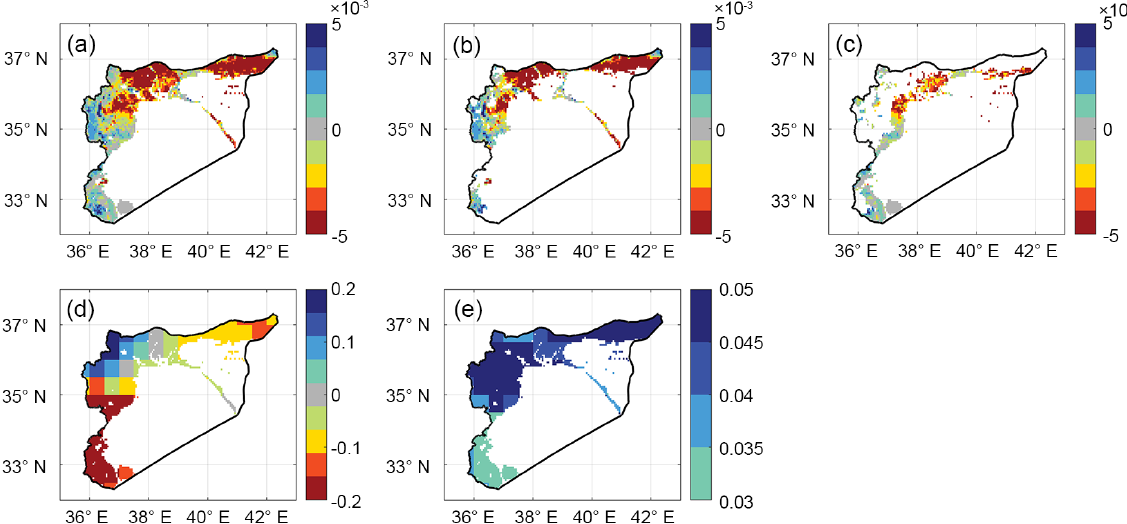
Figure 5. Spatial patterns of interannual trends during 2001–2018 for (a) EVI in the growing period, (b) EVI of croplands, (c) EVI of natural vegetation, (d) precipitation and (e)